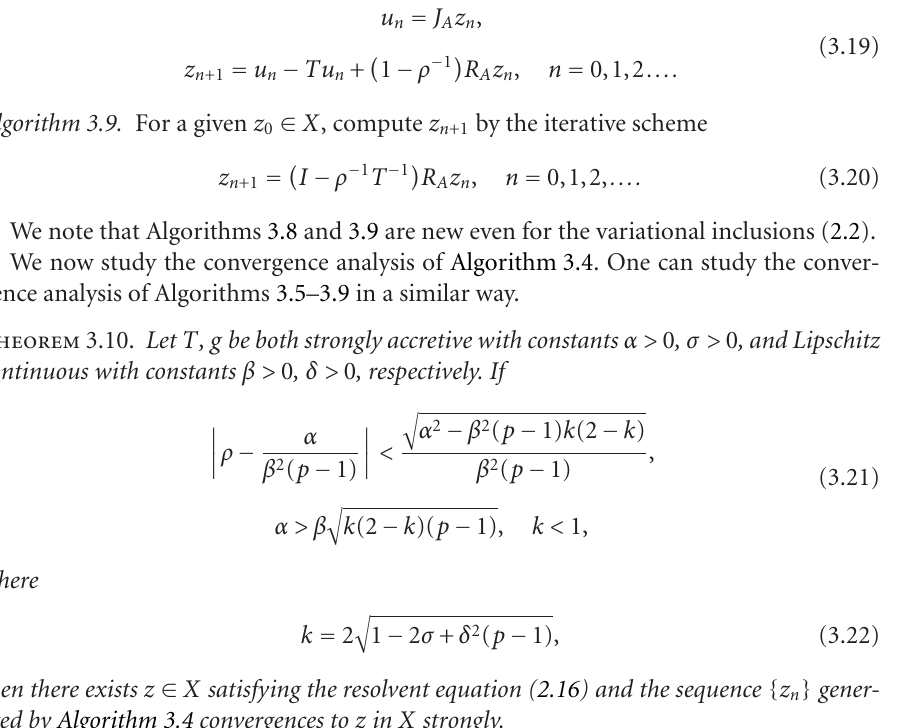
Algorithm 3.8. For a given z 0 ∈ X , compute z n +1 by the iterative schemes